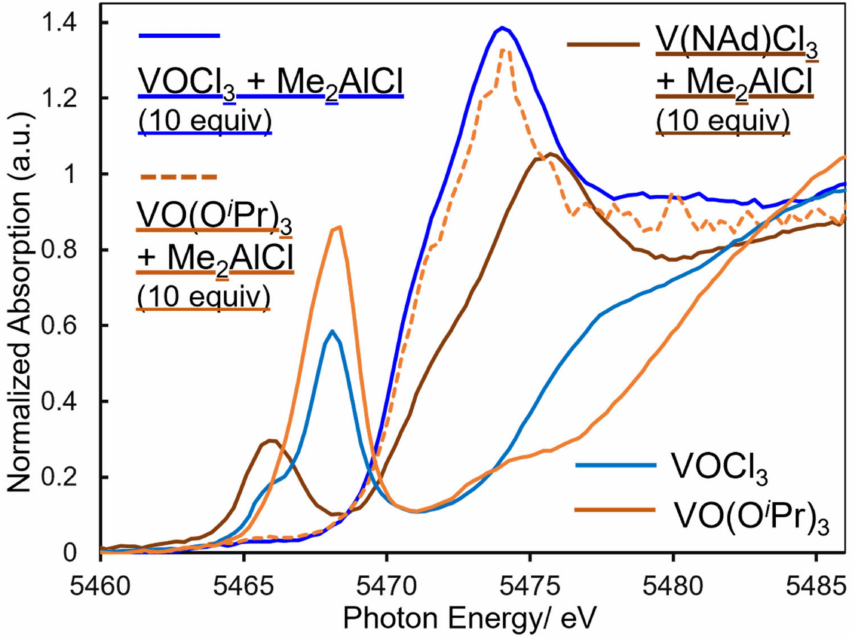
Figure 4. The V K-edge XANES spectra for VOCl 3 , VO(O i Pr) 3 in the presence of Me 2 AlCl (in toluene at 25 ◦